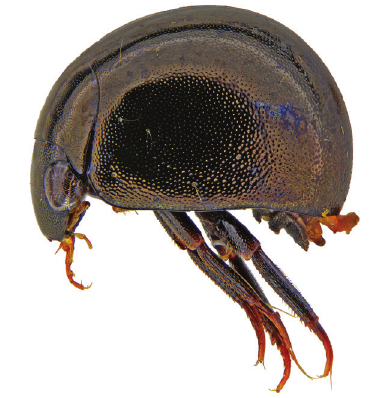
Figure 13. Allocotocerus sp. 4.3 mm, iSimangaliso Wetland Park, False Bay (site 27), February 2015 DT Bilton, MS Bird & R Perissinotto leg.